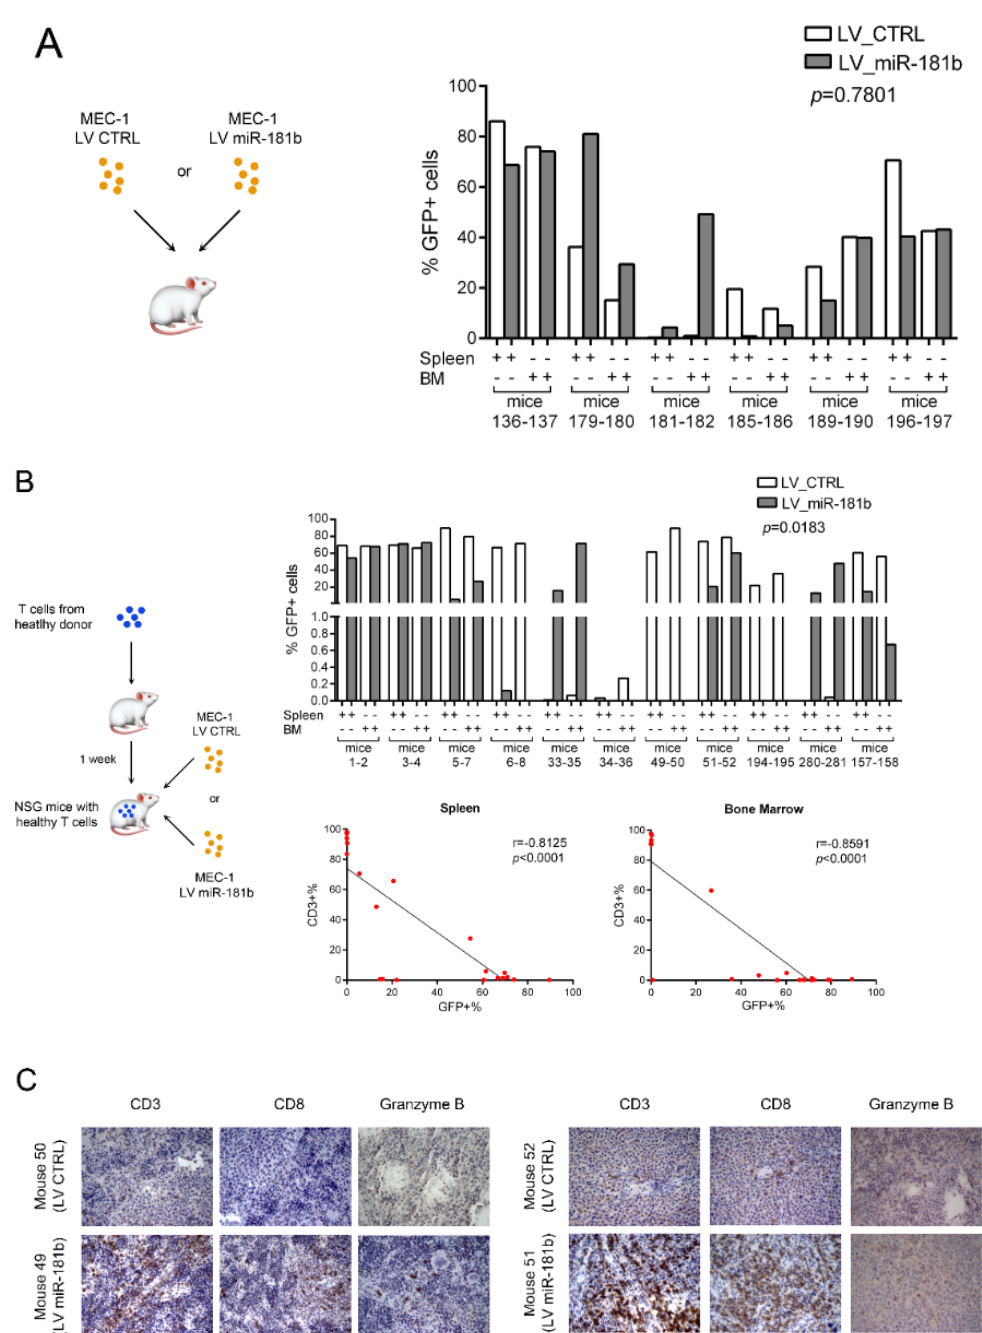
Figure 7. MiR-181b induces death of MEC-1 cells in mice with functional T cells. ( A ) Percentages of GFP+ cells on CD45+ cells in spleen and bone marrow of six pairs of NOD.Cg-Prkdcscid Il2rgtm1Wjl/SzJ (NSG) mice injected (i.v.) with 10 7 infected MEC-1 cells with lentiviral particles encoding GFP alone or with miR-181b . ( B ) (Upper) Percentages of GFP+ MEC-1 cells on CD45+ cells in spleen and bone marrow of 11 pairs of NSG mice. Mice were inoculated with either purified 10 6 T cells from healthy donors or 10 5 CD34+ cells (57% purity) from human cord blood (mice 157 and 158) and re-inoculated with transduced MEC-1 after one week or six months, respectively. p -values were calculated by two-way ANOVA. (Lower) Correlation between the percentage of GFP+ (reported in Figure 6B) and CD3+ cells in spleen and bone marrow of mice; statistical significance was assessed by Pearson’ correlation. Flow cytometry gating strategies used in the experiments are reported in Figure S12. ( C ) Immunohistochemical analysis for CD3, CD8, and granzyme B on spleen sections from two pairs of mice. Pictures were acquired with a Leica microscope using Leica application suite V 4.8.0 software (400X magnification).